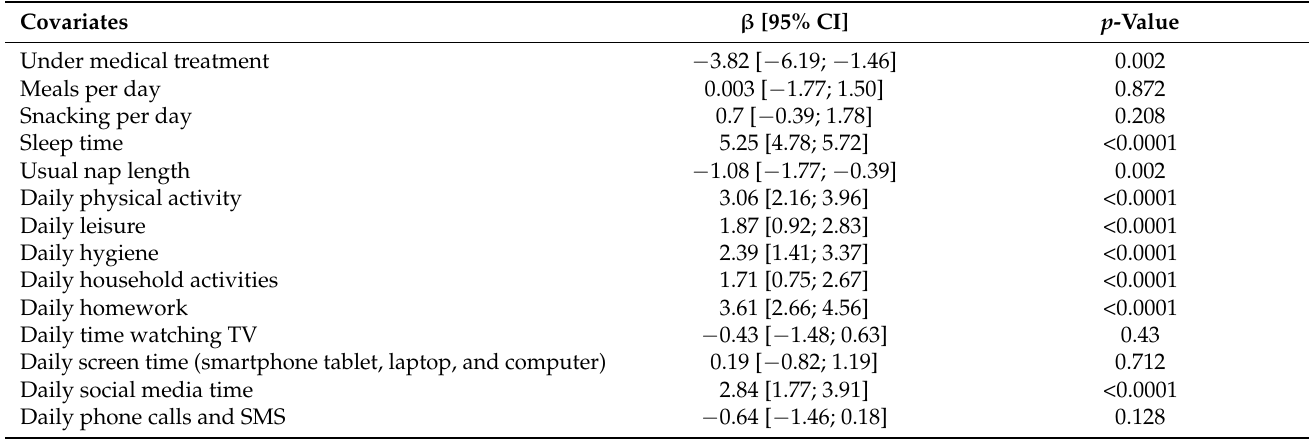
Table 3. Multiple linear regression of EQ-VAS score on daily lifestyle